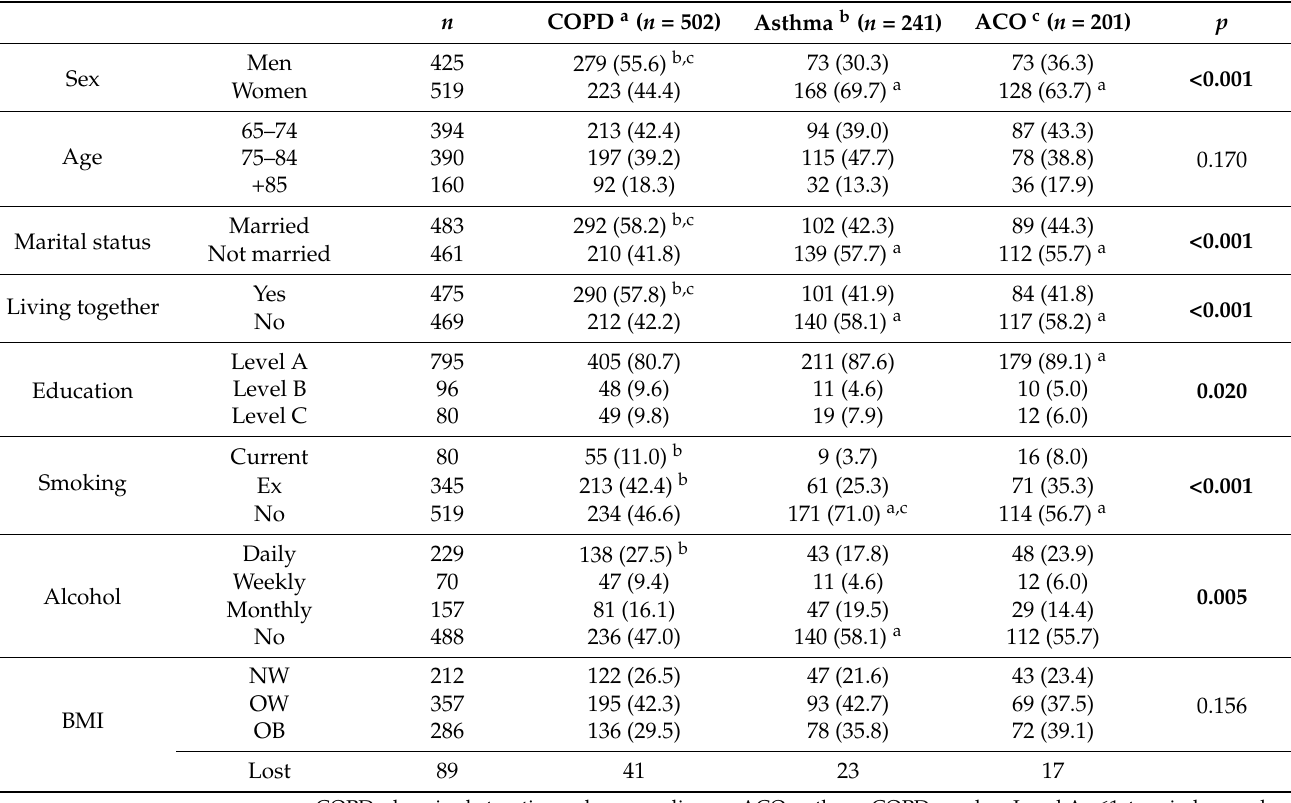
Table 1. Differences in sample characteristics considering chronic respiratory diseases